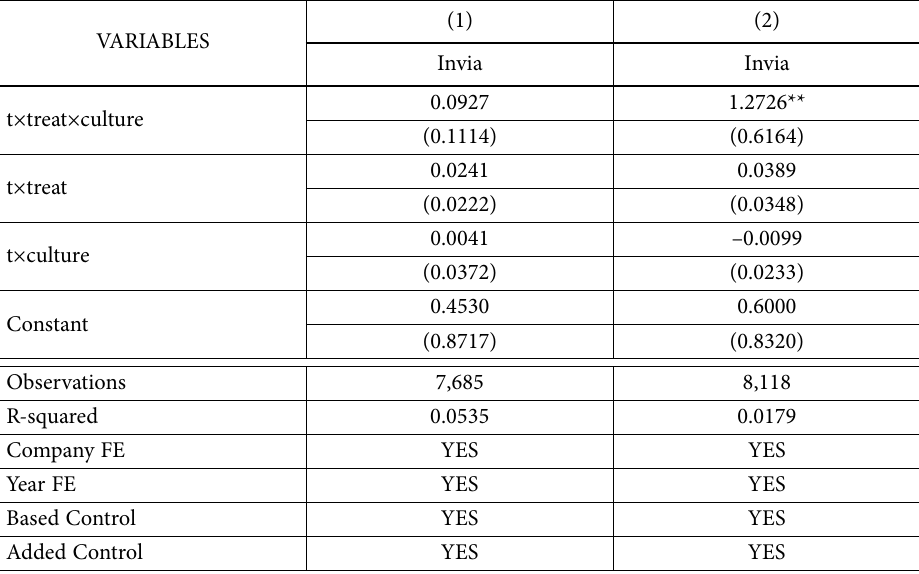
Table 9. Technology-intensive and non-technology-intensive enterprises (1) VARIABLES